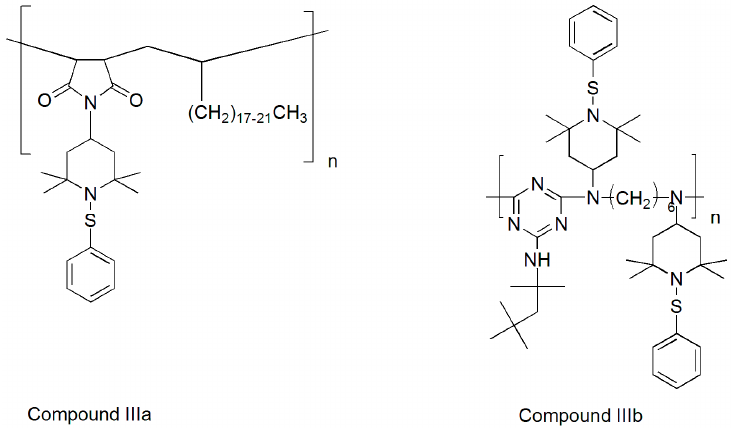
Figure 4. Tentative structures for polymeric compounds IIIa and IIIb.